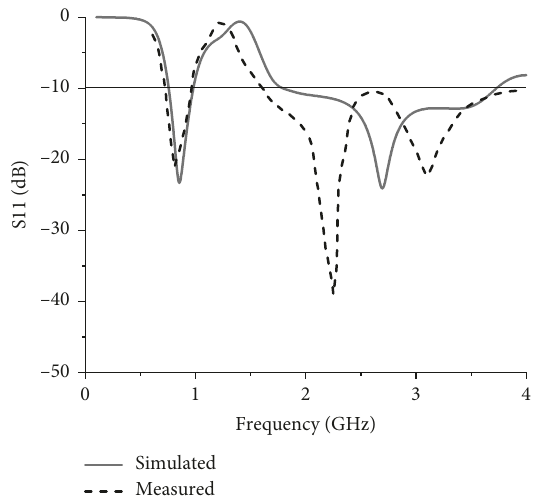
Figure 10: The simulation and measurement of two-vehicle antennas.